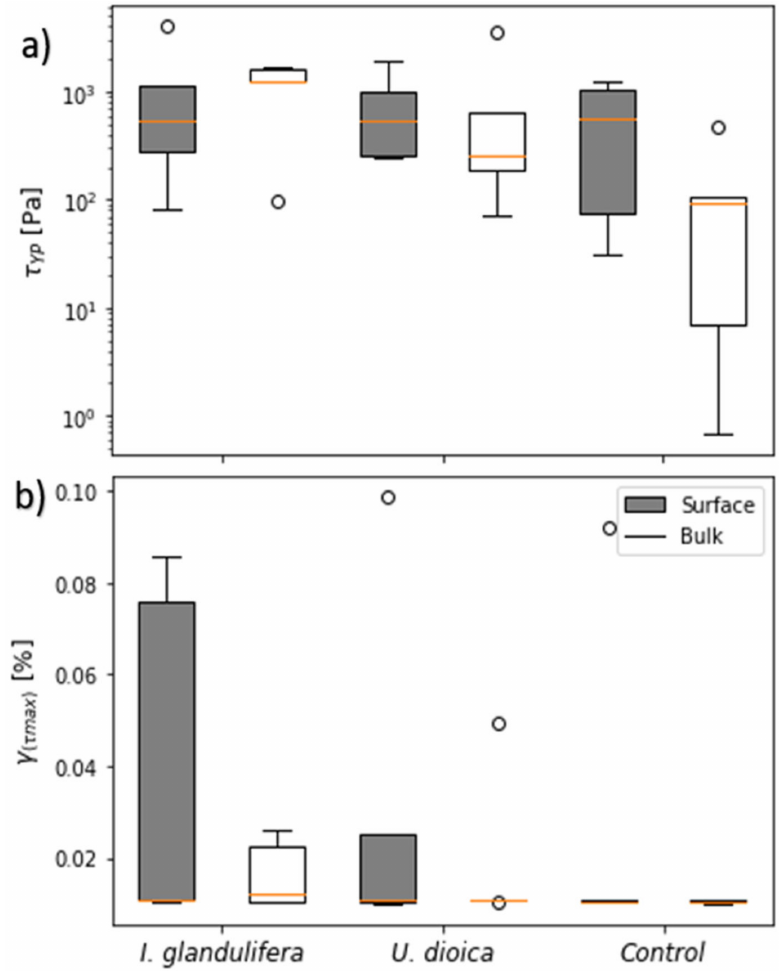
Figure 5. Microstructural stability expressed as ( a ) shear stress at the yield point ( τ YP) in Pa, and ( b ) corresponding strain to the maximum shear stress γτ max for surface (0–2 cm) and bulk layers (2–5 cm depth) of soil colonized by Impatiens glandulifera ( I. glandulifera ) and by Urtica dioica ( U. doica ) or of bare soil (Control). The boxes present the lower and upper 25th percentiles with whiskers showing the 1.5 fold interquartiles range (IQR) and all data points outside the 1.5 fold IQR depicted as empty